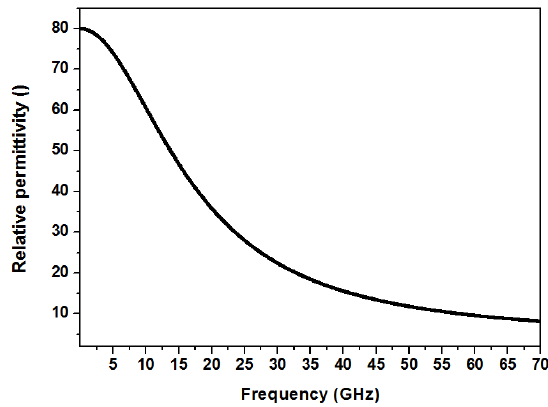
Figure 3. Dielectric permittivity of water as a function of frequency. The characteristic frequency of the single Debye relaxation is 17 GHz.